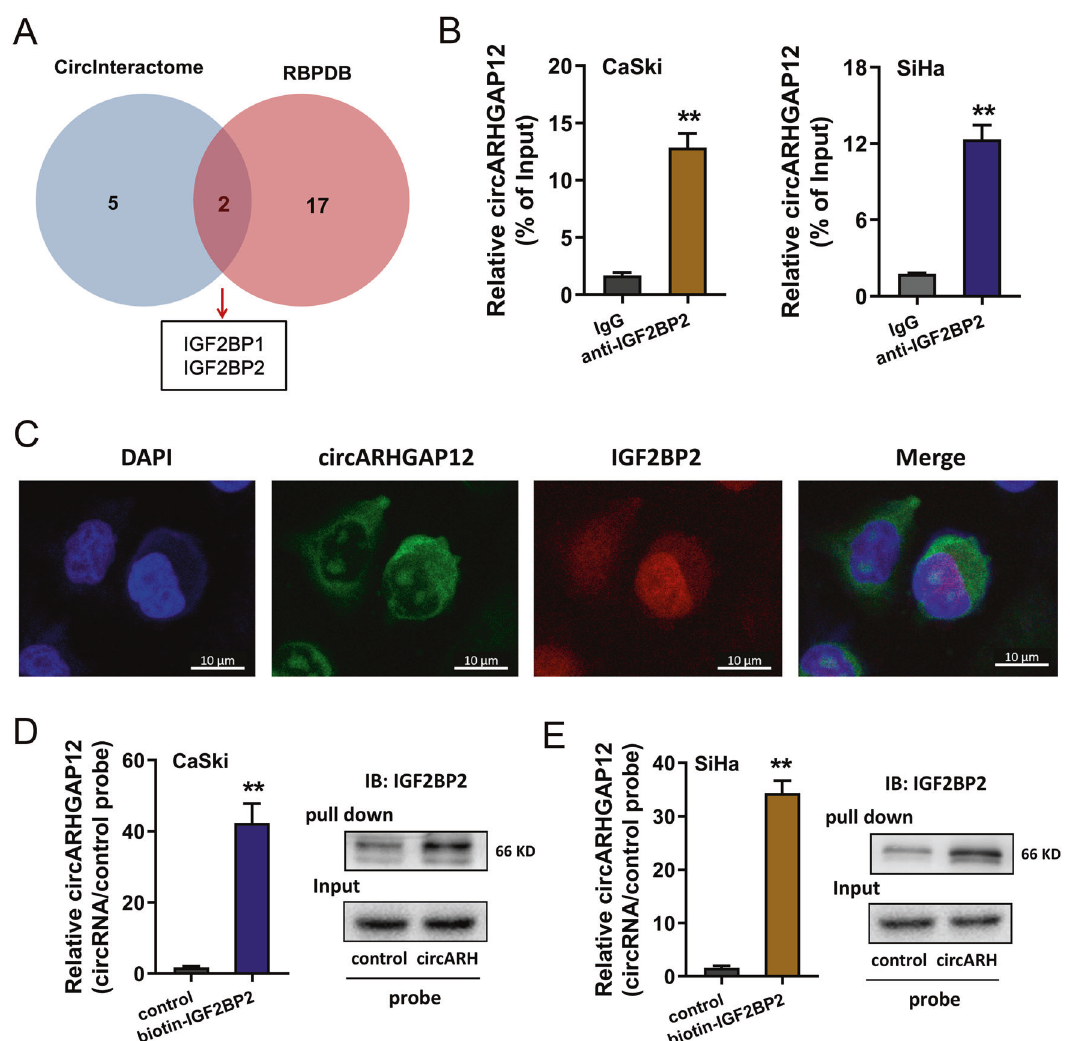
Fig. 4 circARHGAP12 interacted with m 6 A reader IGF2BP2. A Online bioinformatics tool (https://circinteractome.nia.nih.gov/, http://rbpdb. ccbr.utoronto.ca/) found that circARHGAP12 might interact with the RNA binding protein (RBP) IGF2BP1 and IGF2BP2. B RBP immunoprecipitation (RIP) assay following qPCR demonstrated the enrichment of circARHGAP12 in the anti-IGF2BP2 or IgG antibody group (CaSki, SiHa). C Fluorescence in situ hybridization (FISH) assay illustrated the distribution of circARHGAP12 and IGF2BP2 in cervical cancer (CaSki) cells. CircARHGAP12 was labeled with the FAM (green) and IGF2BP2 was labeled with the cy3 (red). D , E Biotin-labeled RNA pull-down was performed using circARHGAP12 probe and control probe. The enrichment of circARHGAP12 was measured using RT-qPCR and the level of IGF2BP2 protein was detected using western blot assay. Experiments were performed in triplicate. P values were calculated by Student ’ s t - test. ** p <